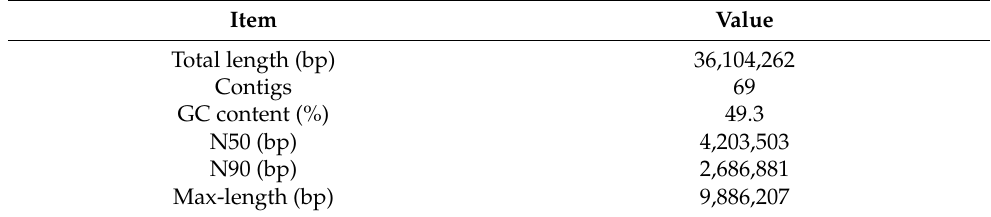
Table 1. General genome features of strain